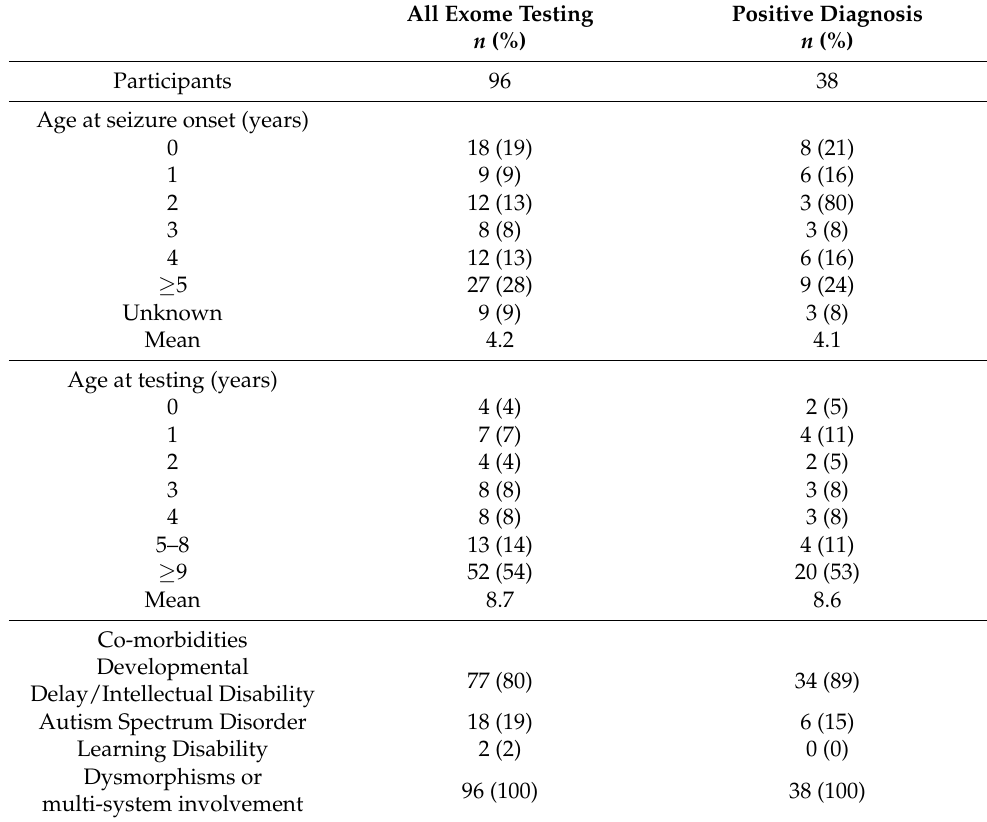
Table 2. Summary of results of whole exome sequencing